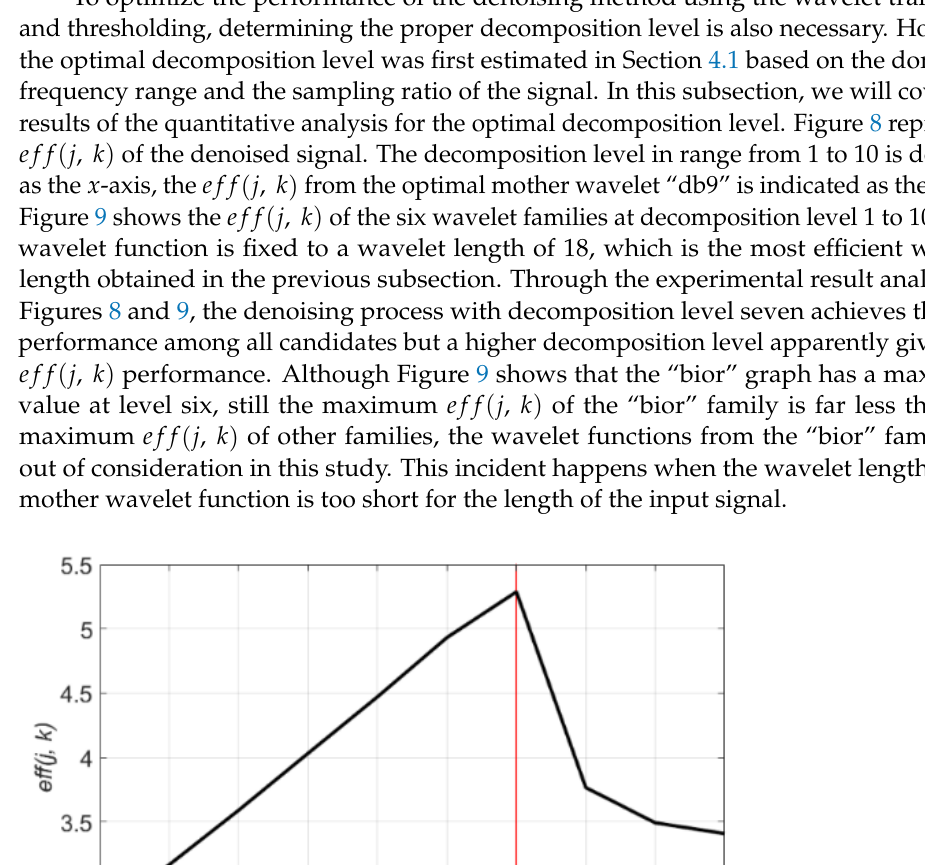
Figure 7. 𝑒𝑓𝑓(𝑗, 𝑘) values of six wavelet families (db, sym, coif, fk, bior, and rbio) for wavelet lengths of: ( a ) 16, ( b ) 18, and ( c ) 20. The used decomposition level 𝑗 is 7.